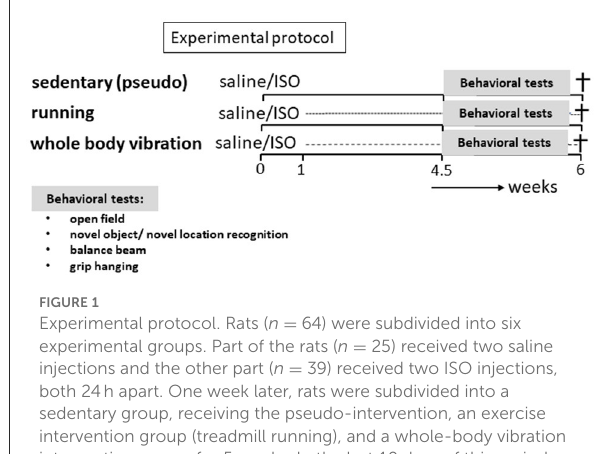
FIGURE1 Experimental protocol. Rats ( n = 64) were subdivided into six experimental groups. Part of the rats ( n = 25) received two saline injections and the other part ( n = 39) received two ISO injections, both 24h apart. One week later, rats were subdivided into a sedentary group, receiving the pseudo-intervention, an exercise intervention group (treadmill running), and a whole-body vibration intervention group, for 5 weeks. In the last 10 days of this period, behavioral tests were performed, and rats were subsequently killed.